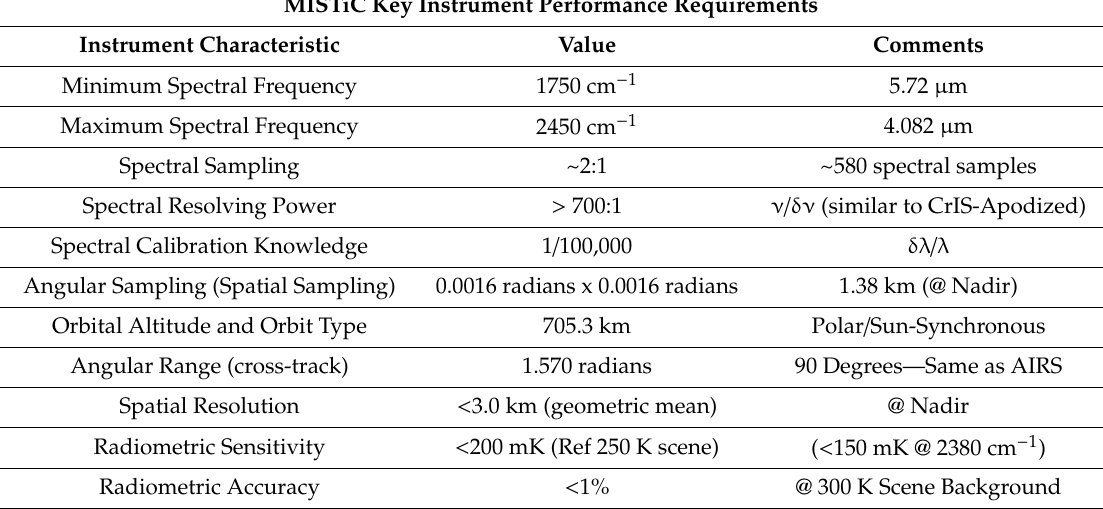
Table 1. Key MISTiC instrument